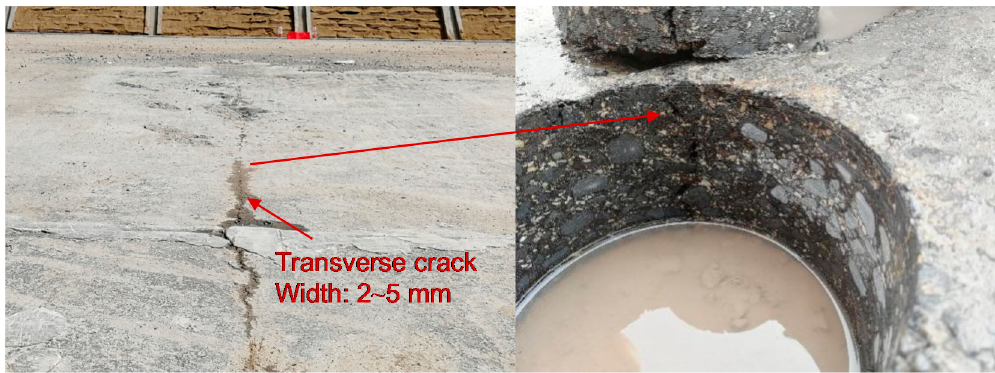
Figure 9. Crack near the expansion joint of the base plate without the geotextile.